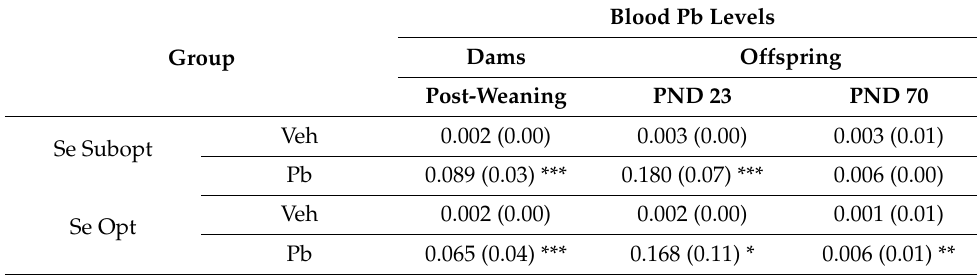
Blood Pb Levels